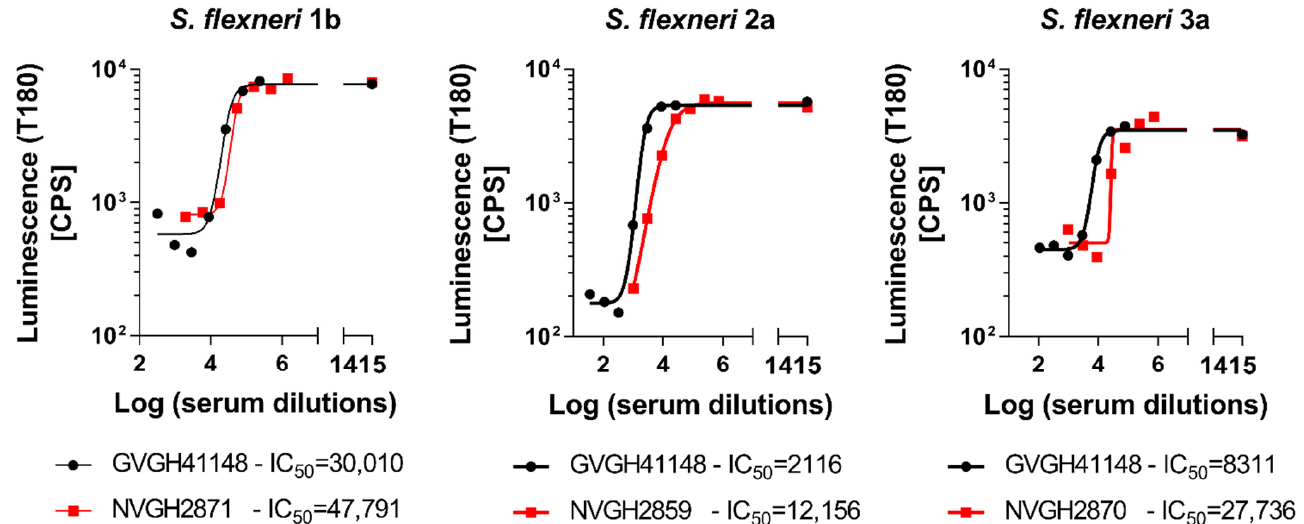
Figure 1. Comparison of pre-clinical L-SBA standard sera (NVGH2871, NVGH2859 and NVGH2870) and human standard serum (GVGH41148) in L-SBA against S. flexneri 1b, 2a and 3a. 4PL fitting of luminescence at T180 (CPS) vs. log-transformed serum dilution. In the graphs, IC50 was obtained by testing mouse standard serum NVGH2871 (for S. flexneri 1b), NVGH2859 (for S. flexneri 2a), NVGH2870 (for S. flexneri 3a), and GVGH41148 (human serum) are reported in open squares and filled circles, respectively.